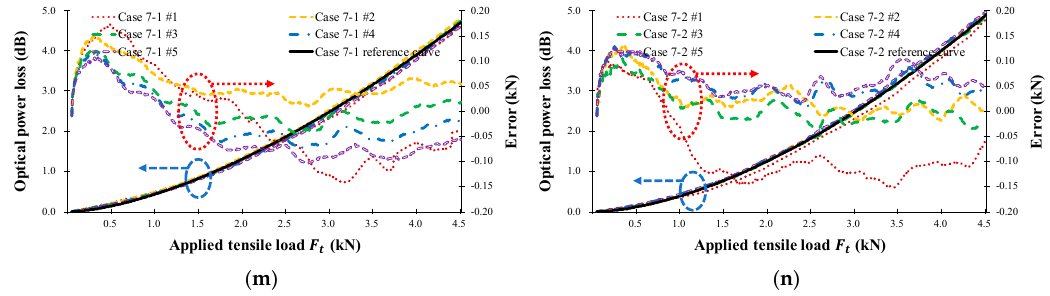
Figure 9. Measured FOS head optical power loss (dB) according to the applied tensile load F t (kN) for the seven types of FRP sensor head in Table 1. ( a ) Case 1-1; ( b ) Case 1-2; ( c ) Case 2-1; ( d ) Case 2-2; ( e )